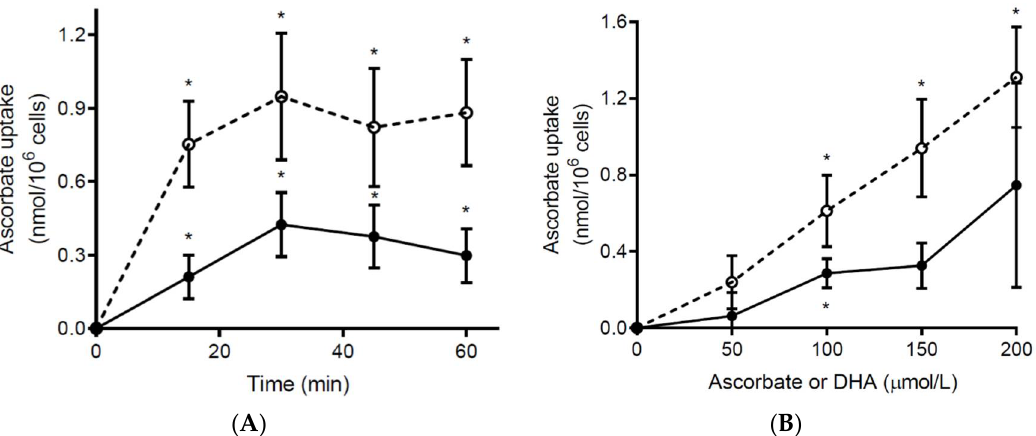
Figure 3. Ascorbate uptake by neutrophils from septic patients. The patients’ neutrophils (5 × 10 6 /mL) were incubated with ascorbate (● solid line) and DHA ( dashed line) at ( A ) a concentration of 200 µmol/L for the indicated times ( n = 4; baseline ascorbate = 0.43 nmol/10 6 cells), or ( B ) at the indicated concentrations for 30 min ( n = 3; baseline ascorbate = 0.46 nmol/10 6 cells). Intracellular ascorbate uptake was determined using HPLC. Data represent mean and SEM, * indicates a significant difference from baseline at p < 0.05 (paired t -test).